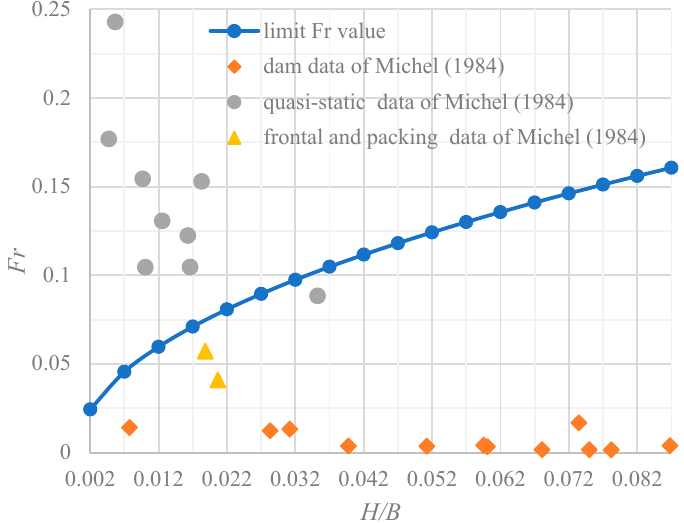
Figure 11. Calculated limiting flow Froude number Fr for natural rivers compared to those of field observations of the La Grande River.